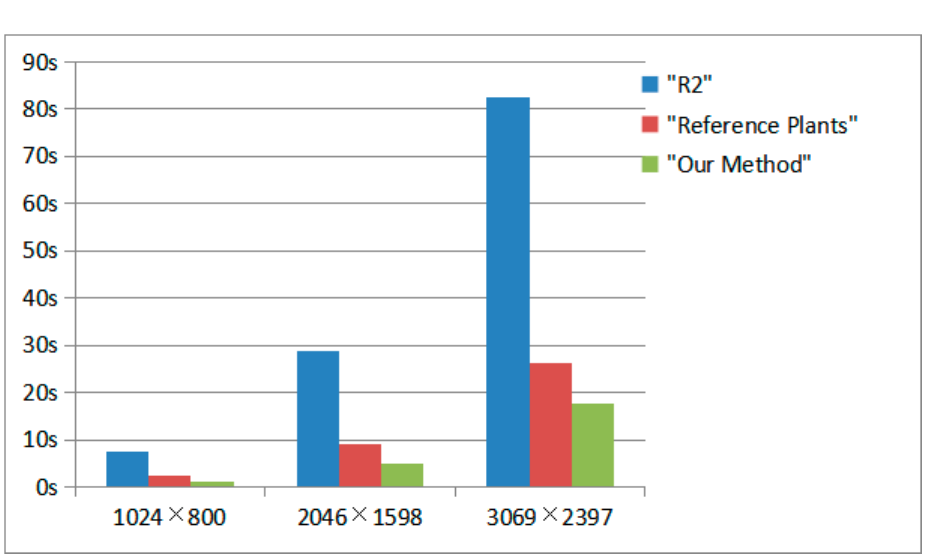
Figure 17. Comparison of results with the data of DEM (30 m resolution): ( a ) visual field range computed using the Matryoshka doll algorithm; and ( b ) viewshed computed using the R3 doll algorithm. The difference in results are enclosed in the red circles in (a).